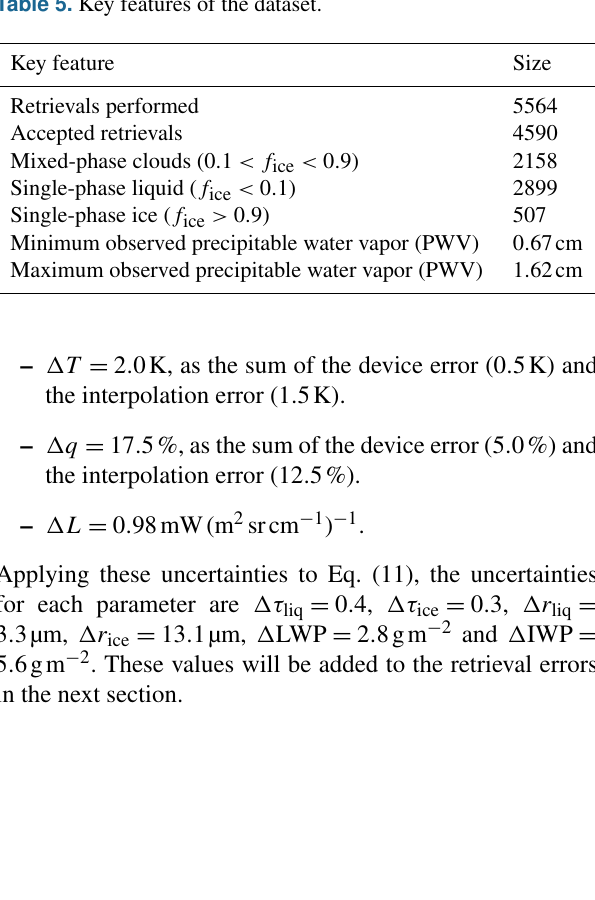
Figure 5. Distribution of retrieved optical depths for liquid wa- ter (a) and ice water (b) . The bin width is set to the sum of the root-mean-square error from Table 3 and the errors discussed in Sect. 4.5. Table 5. Key features of the